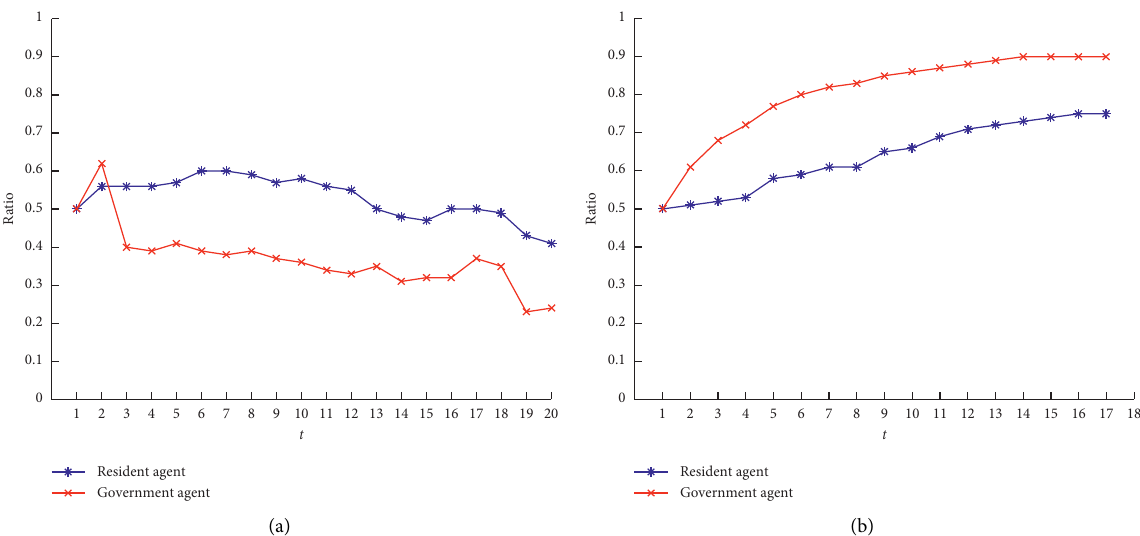
Figure 9: Evolution with binary choice of analysing disaster. (a) Regardless of analysing disaster. (b) Disaster analysis matters.